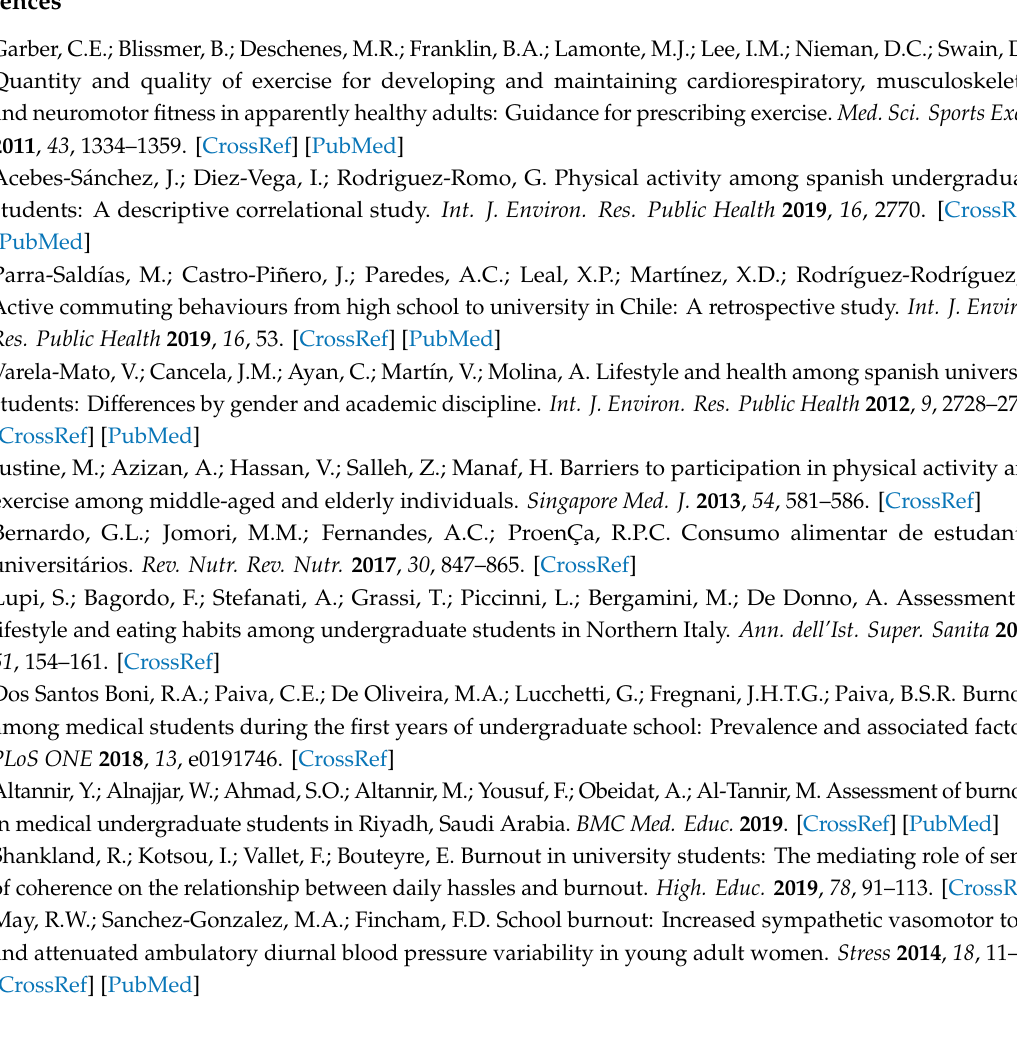
Figure S1: Exchange gas data during a graded exercise test